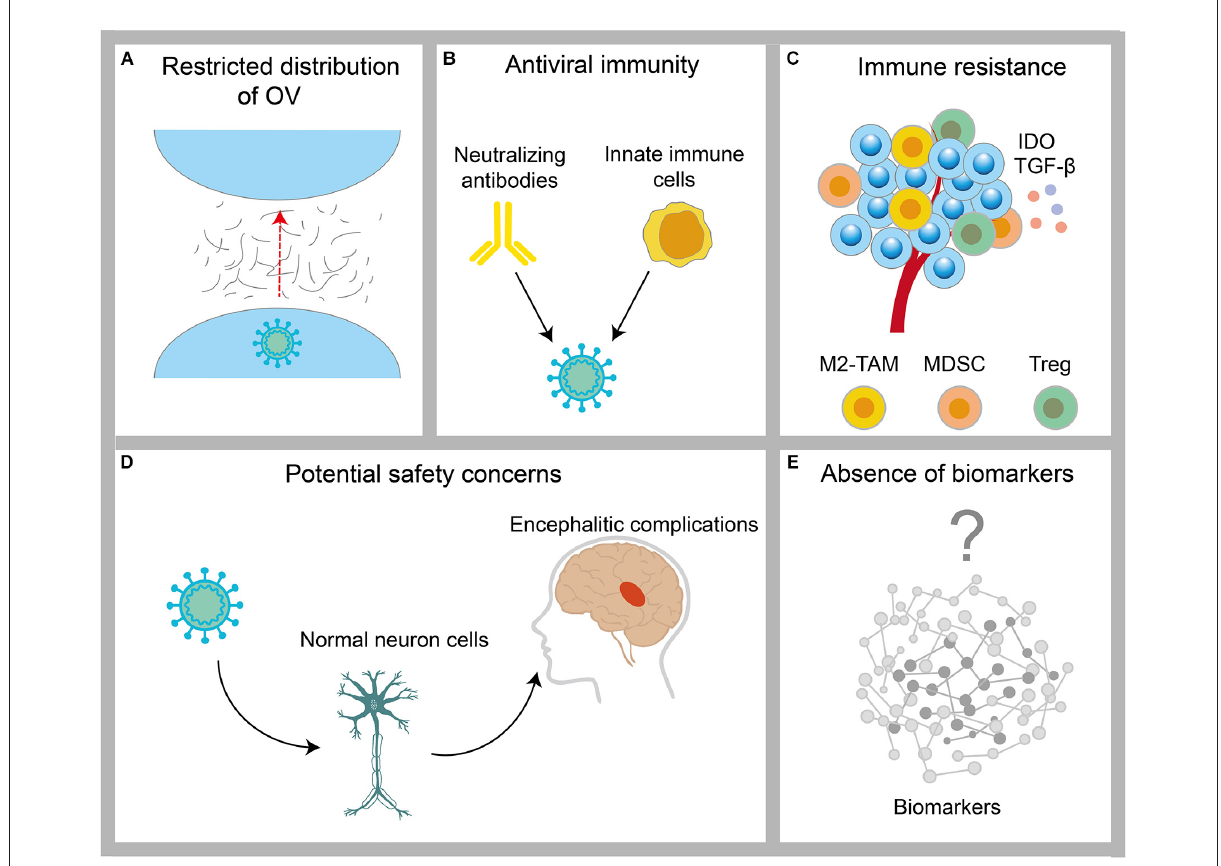
FIGURE3 Challenges encountered by OV in the treatment of GBM. (A) The distribution of OVs is restricted by physical barriers, such as the tumor extracellular matrix. (B) Clearance of OV by host antiviral immunity. (C) Protection of tumor cells by immunosuppressive cells, such as M2- TAM, MDSC, and Treg in the tumor microenvironment. (D) The infection risk of OV to normal neuronal cells. (E) The lack of validated biomarkers of OVs for